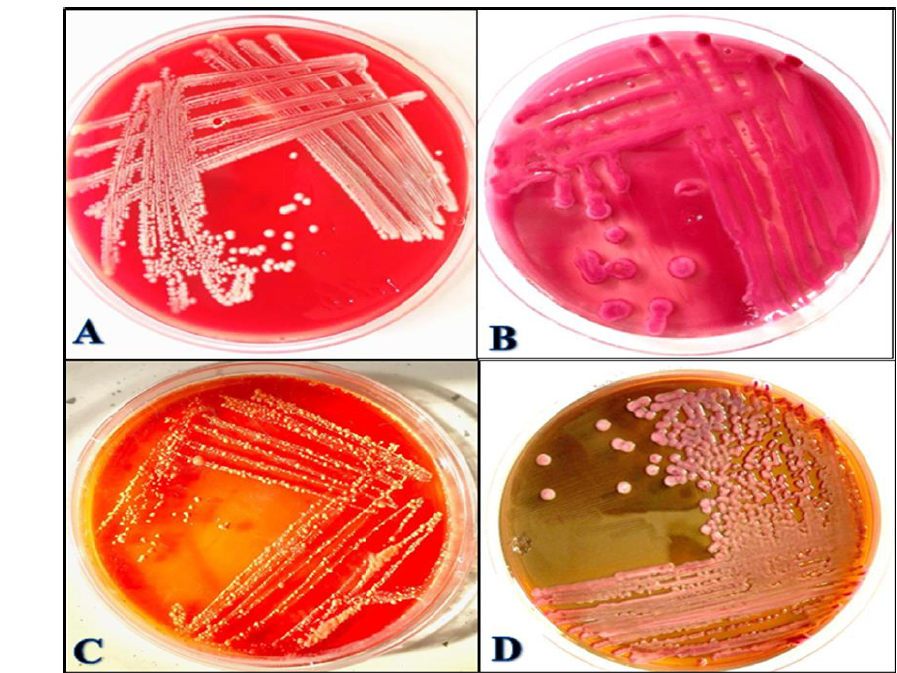
Fig.3. Colonies of K. pneumoniae growing on different culture media after 24 hrs of incubation under aerobic condition .